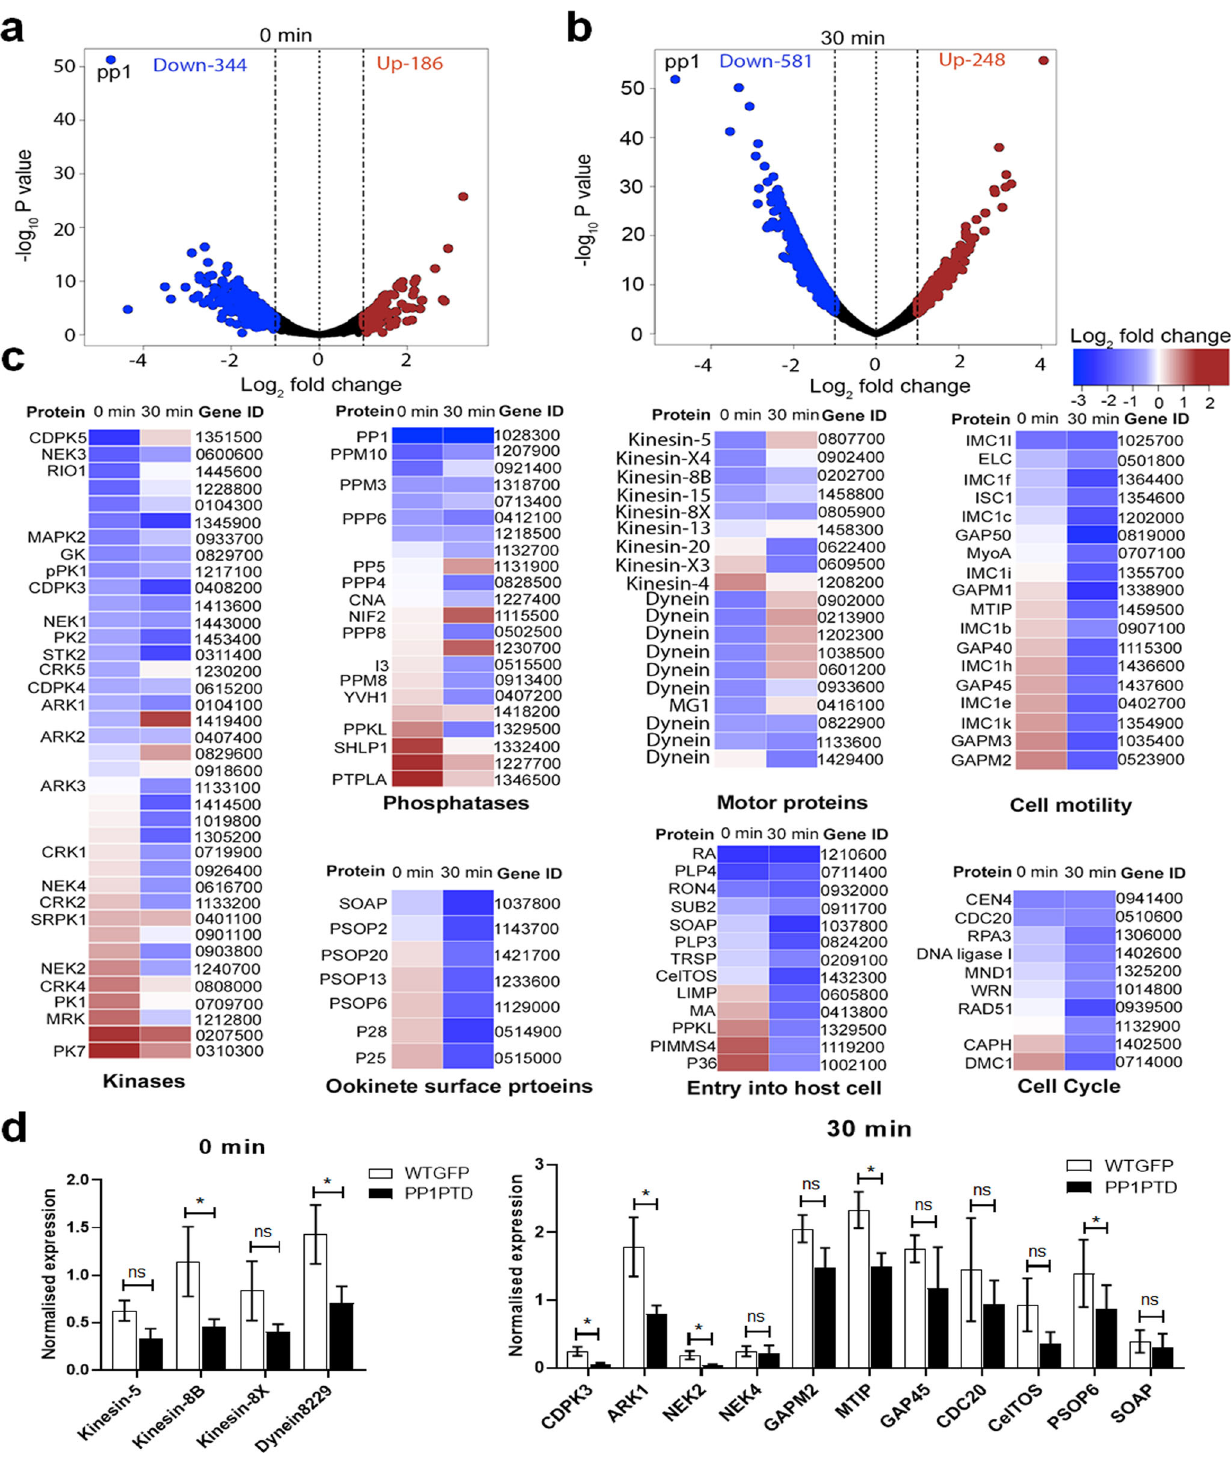
Fig. 6 Transcriptome of PP1PTD mutant reveals important roles of PP1 in parasite cell cycle, motor protein function and cell polarity during gametocyte biology. Volcano plots showing signi fi cantly down-regulated (blue Log 2 fold ≤ − 1, q value < 0.05) and up-regulated genes (brown Log 2 fold ≥ 1, q value < 0.05) in PP1PTD compared to wild-type lines in non (0 min)-activated gametocytes ( a ) and 30 min activated gametocytes ( b ). Non-differentially regulated genes are represented as black dots. c Expression heat maps showing affected genes from speci fi c functional classes of proteins such as kinases, phosphatases, motor proteins and proteins associated with parasite motility, entry into the host cell, ookinete surface and cell cycle. Genes are ordered based on their differential expression pattern in non-activated gametocytes. d Validation by qRT-PCR of a few genes randomly selected based on the RNA- seq data. All the experiments were performed three times in duplicate with two biological replicates. * p ≤ 05.